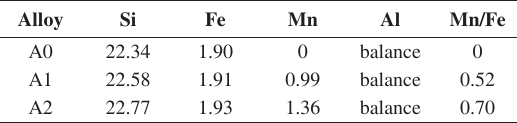
Table 1. Chemical composition of the experimental alloys (% w/w).